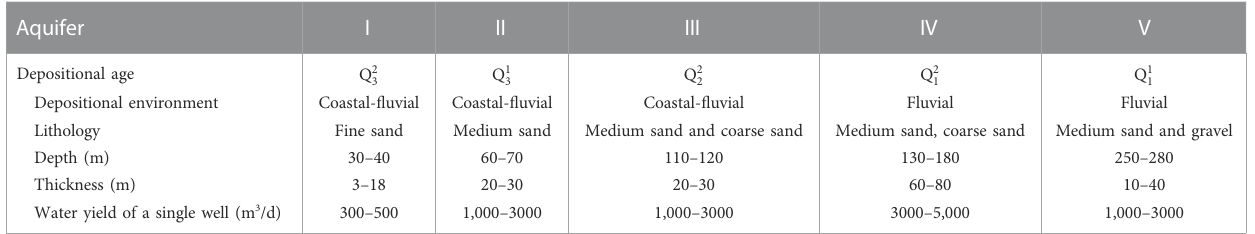
TABLE 1 Characteristics of aquifers in the study